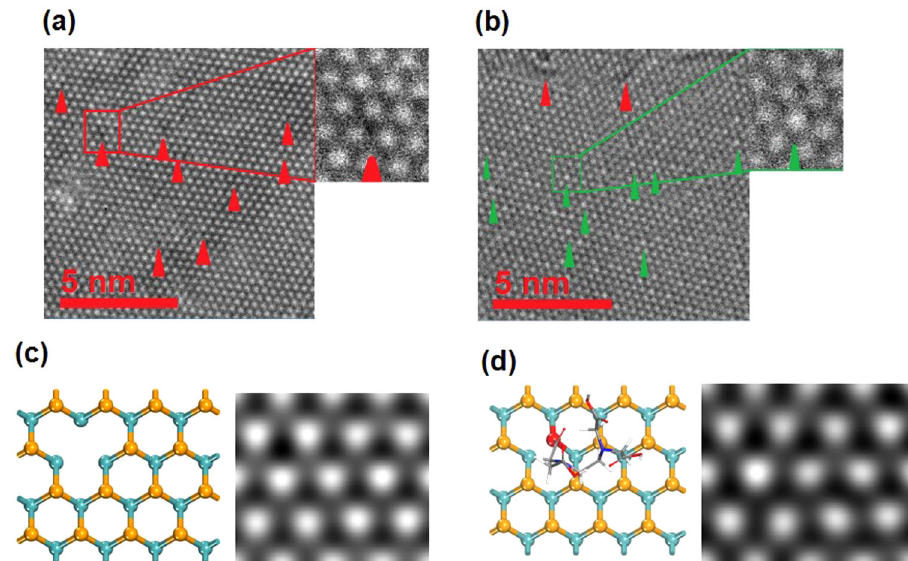
Fig. 3 The atomic vacancy dynamics revealed by HRTEM. a The HRTEM image of the unprocessed SLM sheet, red arrows show the double Se vacancy. b HRTEM photograph of processed monolayer MoSe 2 , red arrows show the double Se vacancy, green arrows show the double Se vacancy processed by one side with EDTA. c Double Se vacancy in monolayer MoSe 2 and its simulated TEM photograph. d Double Se vacancy processed by one side with EDTA in monolayer MoSe 2 and its simulated TEM